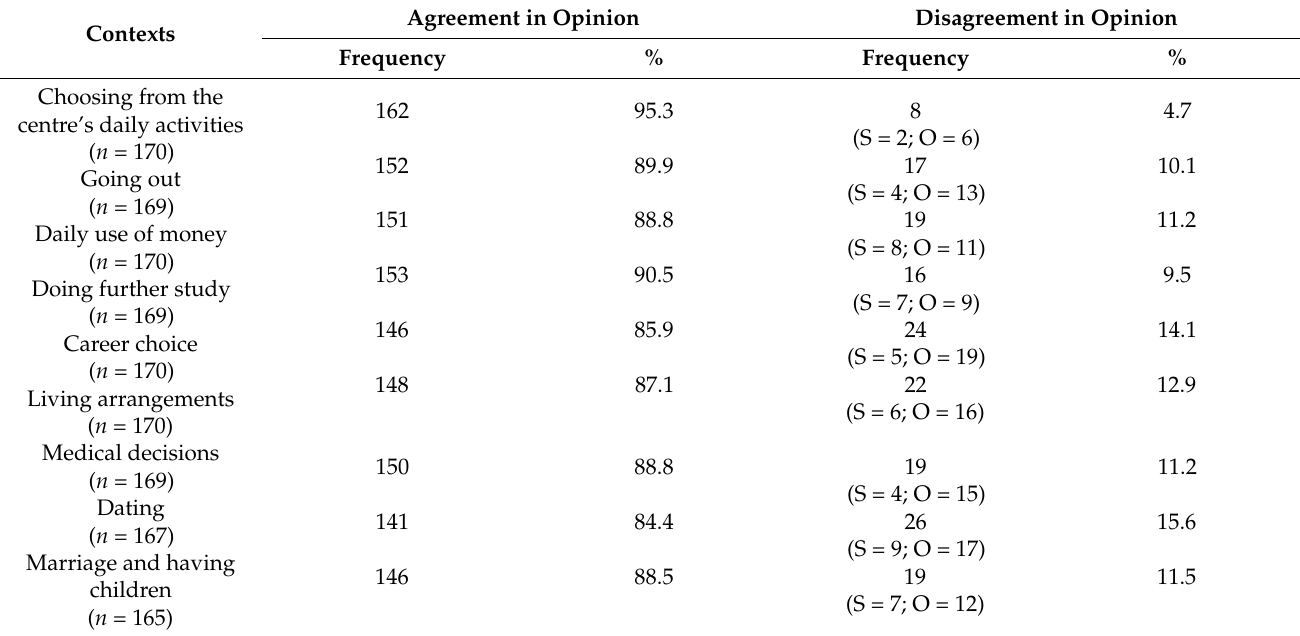
Table 5. Frequency of Agreement and Disagreement about Decisions in Different